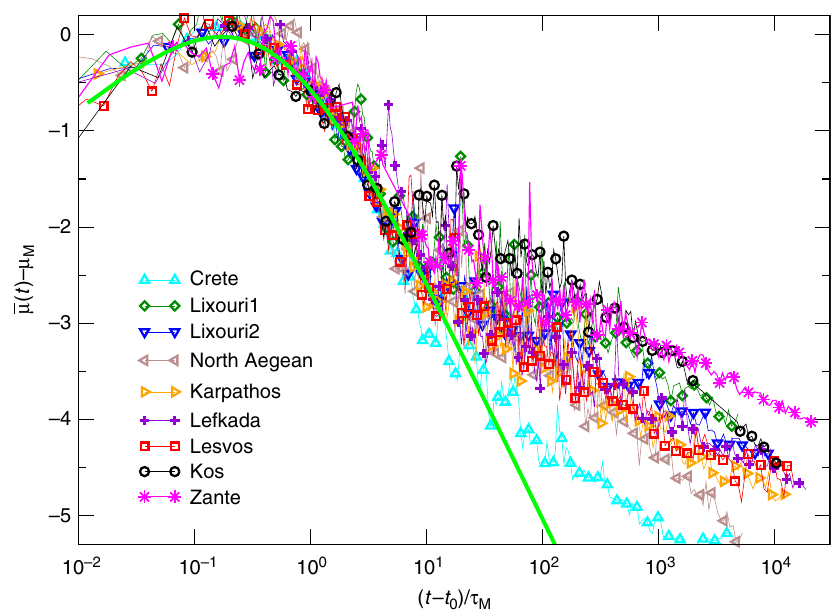
Fig. 3 The average envelope function of the recent Aegean earthquakes. The quantity (cid:2) μ = 39.0 s for Lixouri1, τ τ M τ M = 22.6 s for Kos, and τ M = 11.4 s for Zakynthos. The green continuous line is the scaling function F ( x ) = log